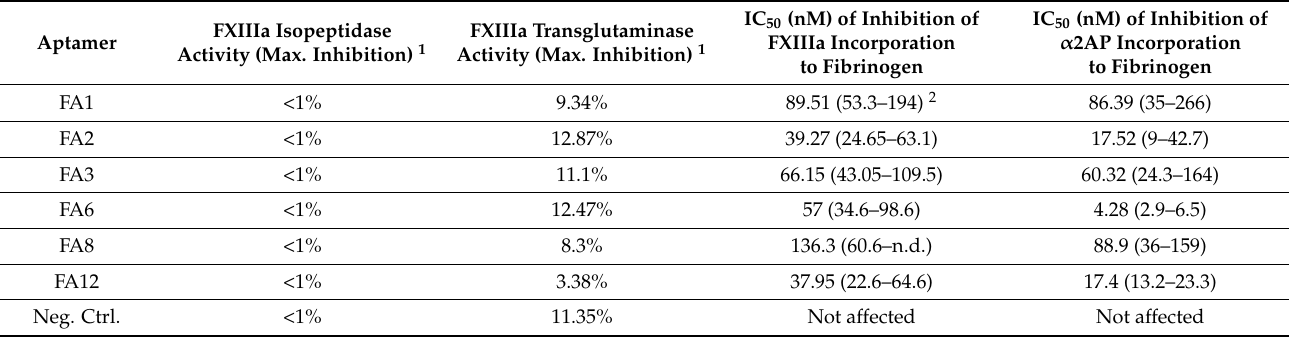
Figure 1. Effect of the FXIIIa-binding aptamers on FXIIIa catalytic activity. ( A ) Isopeptidase acitivity. Hydrolysis rates of the peptide substrate Abz-NE(CAD-DNP)EQVSPLTLLK-OH was measured at λ ex 310 nm and λ em 420 nm after incubation of FXIIIa (12.8 nM) with increasing concentrations of aptamers or controls. ( B ) Transglutaminase activity. FXIIIa (4 nM) was incubated with increasing concentrations of aptamers or controls and reacted with a synthetic peptide substrate to finally measure the reduction of absorbance at 340 nm according to released ammonia and decreased NADH. Data are shown as means of triplicates ±SD. ● FA1, ■ FA2, ▲ FA3, ▼ FA6, ♦ FA8, ○ FA12, □ negative control sequence, ∆ Tridegin. Table 2. Key characteristics of FXIIIa